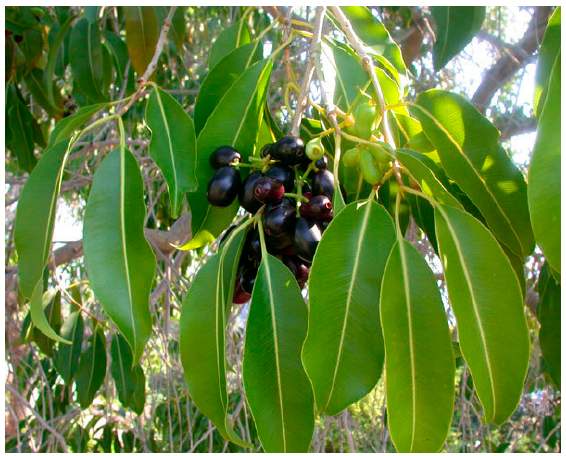
Figure 14. Eugenia jambolana .